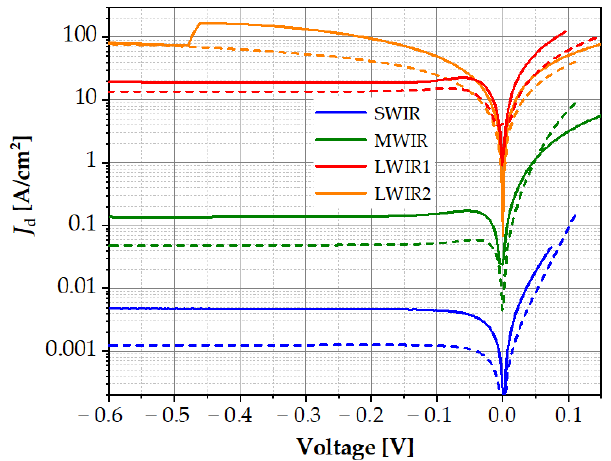
Figure 4. Experimental (solid line) and theoretical (dashed line) I–V characteristics of SWIR, MWIR, and LWIR diodes at the temperature of 300 K.